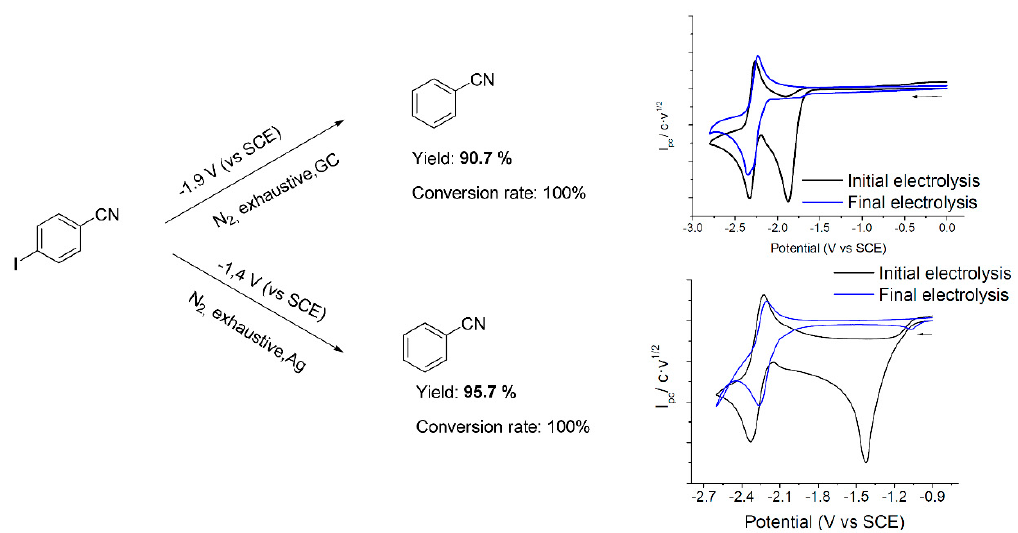
Figure 3. Experimental conditions and the cyclic voltammogram of a 5 mL solution of 1 (10 mM) before (black line) and after (blue line) controlled potential electrolysis under an inert atmosphere with a glassy carbon electrode (top) and silver electrode (bottom). Scan rate: 0.5 V s − 1.